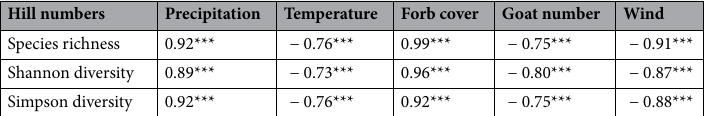
Table 1. Pearson correlation coefficients of Hill numbers with environmental